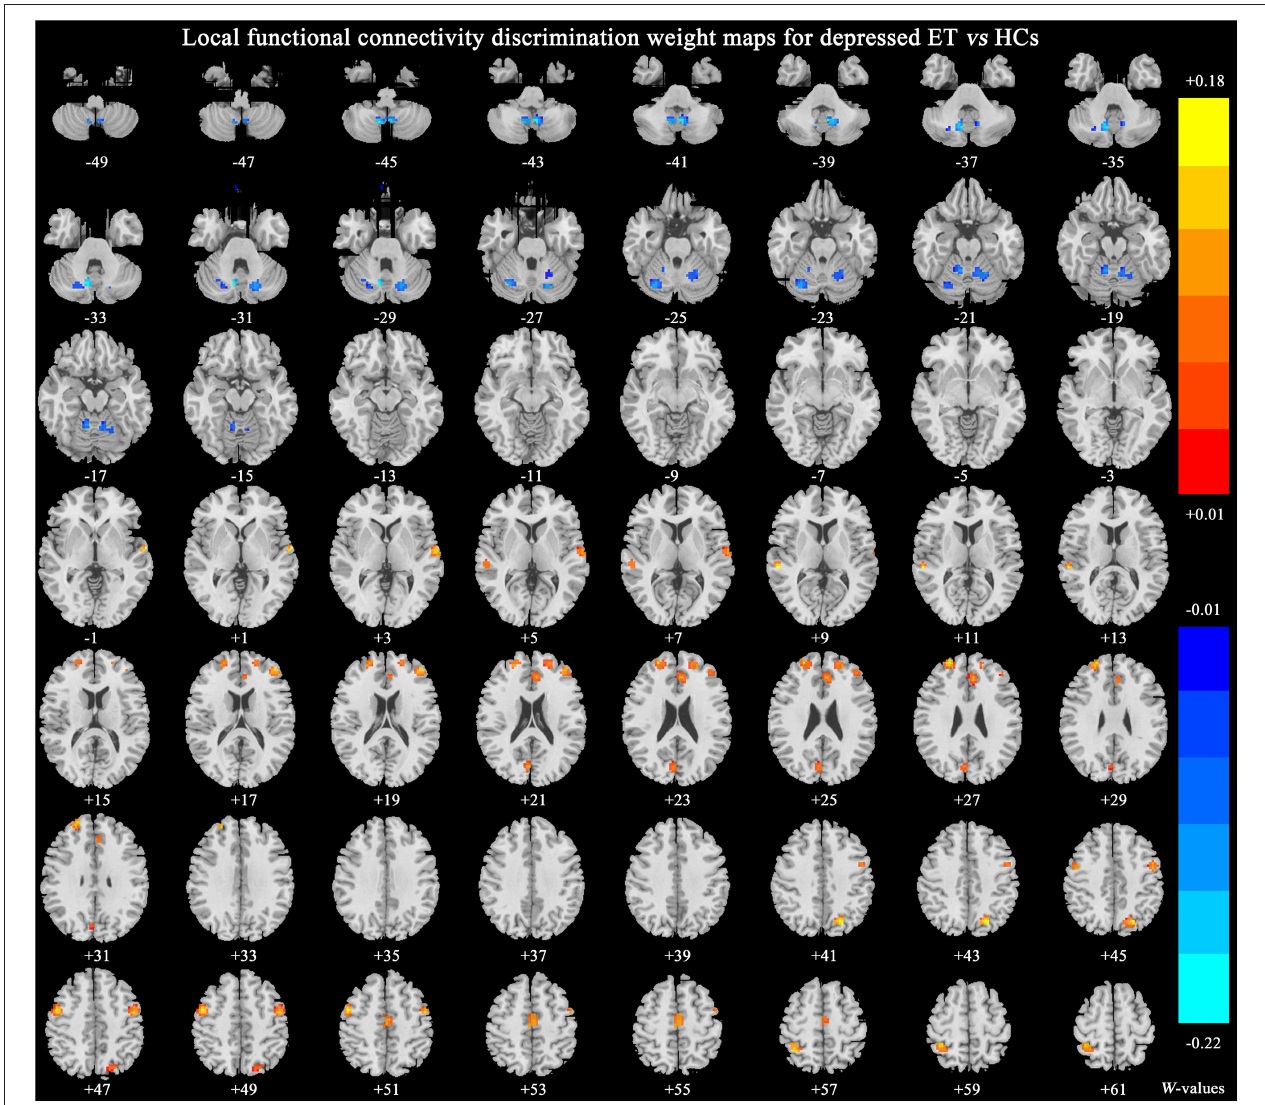
FIGURE 2 | The brain regions of significant discriminative features in the classification of depressed ET vs. HCs. ET, essential tremor; HCs, healthy